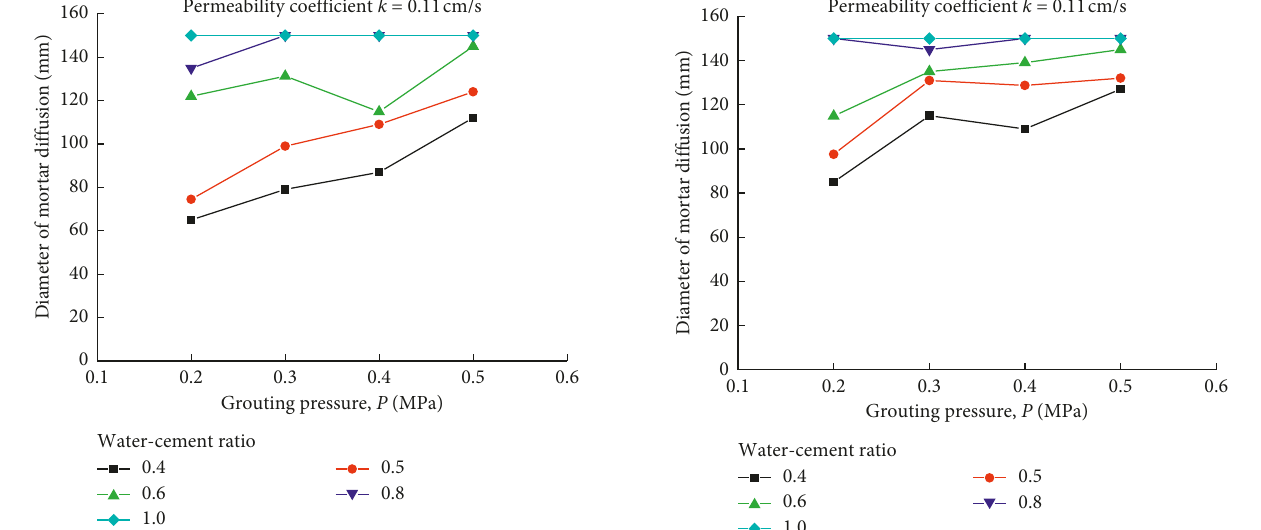
Figure 12: Characteristics of slurry diffusion ( k